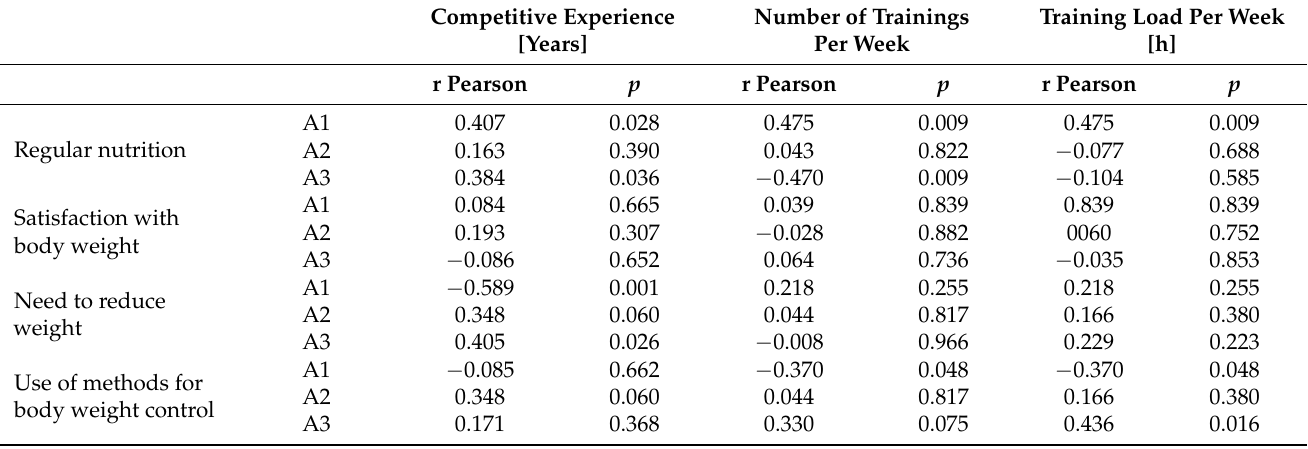
Table 8. Eating habits, satisfaction with body weight, a need to reduce it, and the use of methods for body weight control versus competitive experience, the number of training sessions per week and, training load per week. Competitive Experience Number of Trainings Training Load Per [Years] Per Week